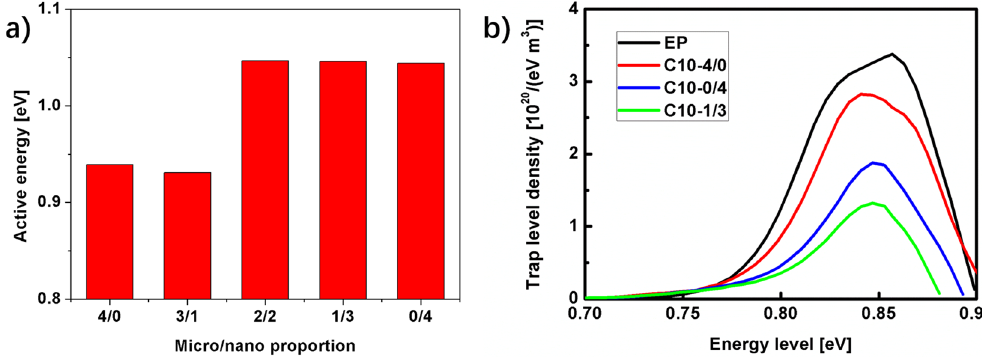
Figure 6. ( a ) The active energy of epoxy/SiO2 composites with different micro/nano proportions at 10 wt%. ( b ) The trap level density distribution of EP, C10-4/0, C10-1/3 and